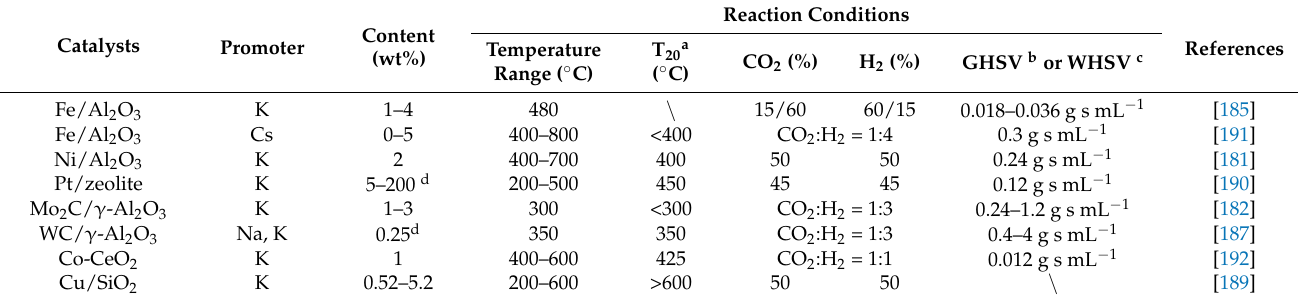
Table 9. Summary of catalysts and reaction conditions for reverse water-gas shift (RWGS) catalysts promoted by alkali